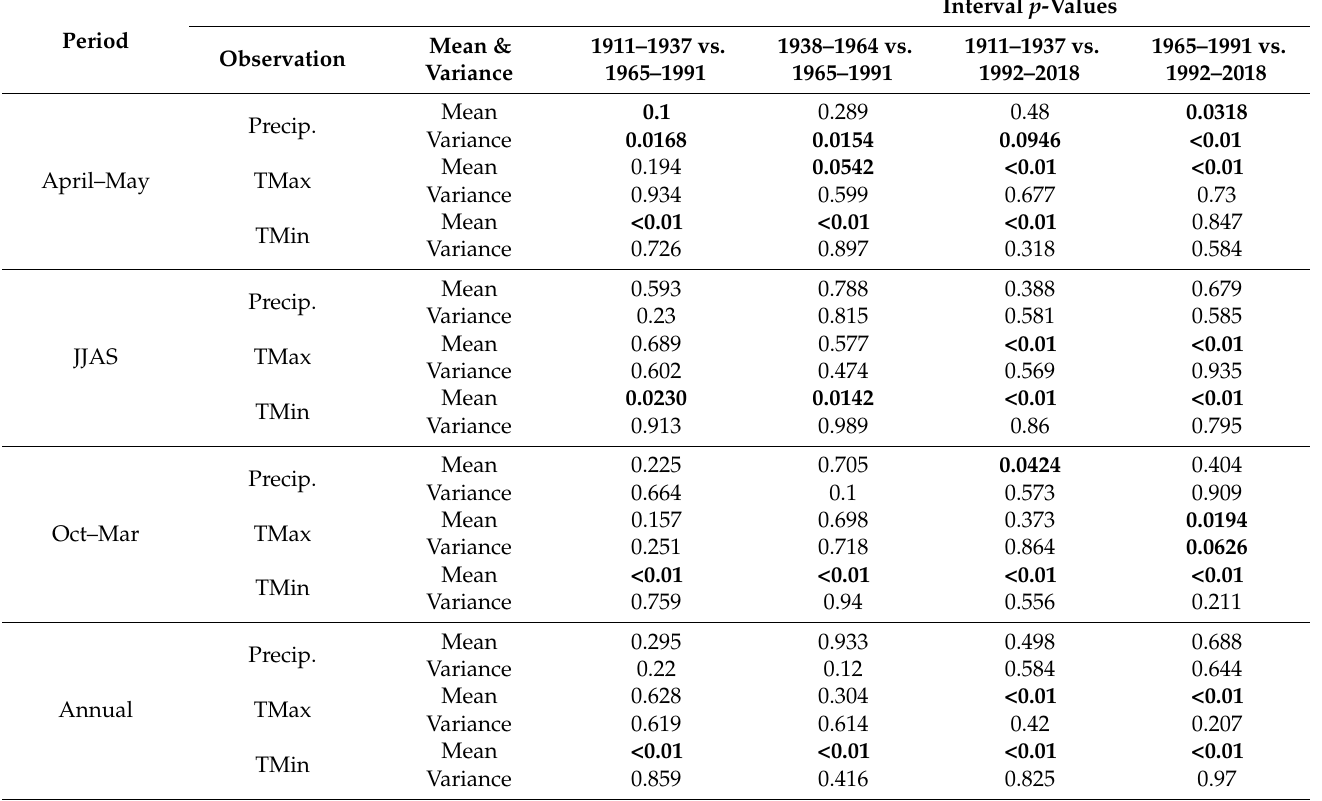
Table 1. p -values from permutation testing differences in interval means and variances. p -values from permutation testing differences in interval means and variances for, April–May, JJAS, October– March and annual precipitation, TMax and Tmin, based on area averages of observing stations in the northeast part of the northern Murray-Darling Basin. Significant values ( p < 0.10) are italicised in bold. Note that the p -value for each variance test is calculated after one sample has had bias correction in the mean. Key points to note are the highly significant p -values ( p < 0.05) for April–May mean and variance precipitation decreases from 1965–1991 to 1992–2018; and highly significant increases generally in mean TMin and also generally in mean TMax for most of the periods.